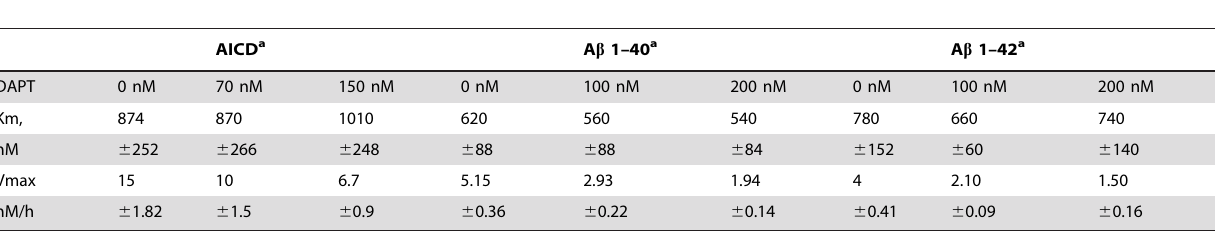
a the best fit values 6 standard error were calculated using nonlinear regression and the eqn. 4.